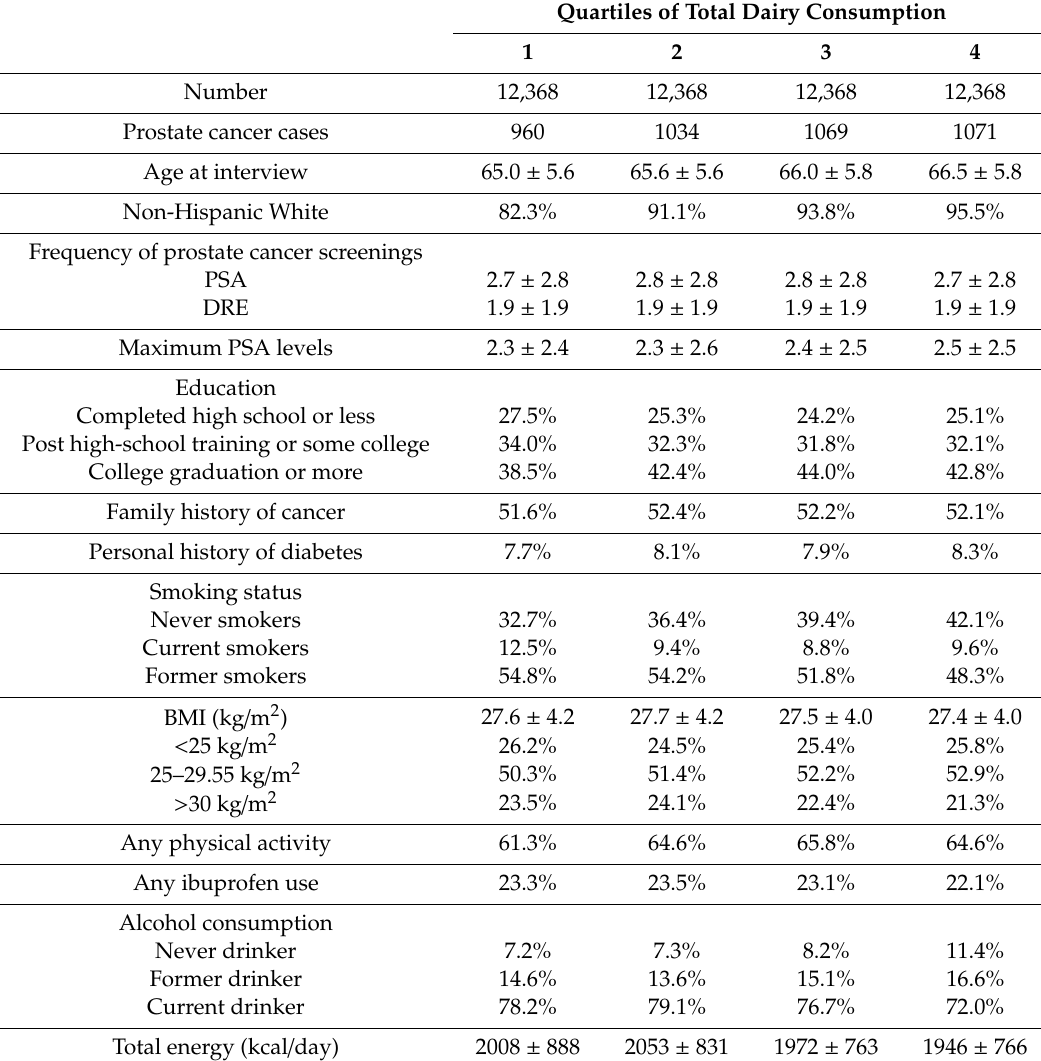
Table 1. Characteristics of the study population by quartiles of total dairy consumption